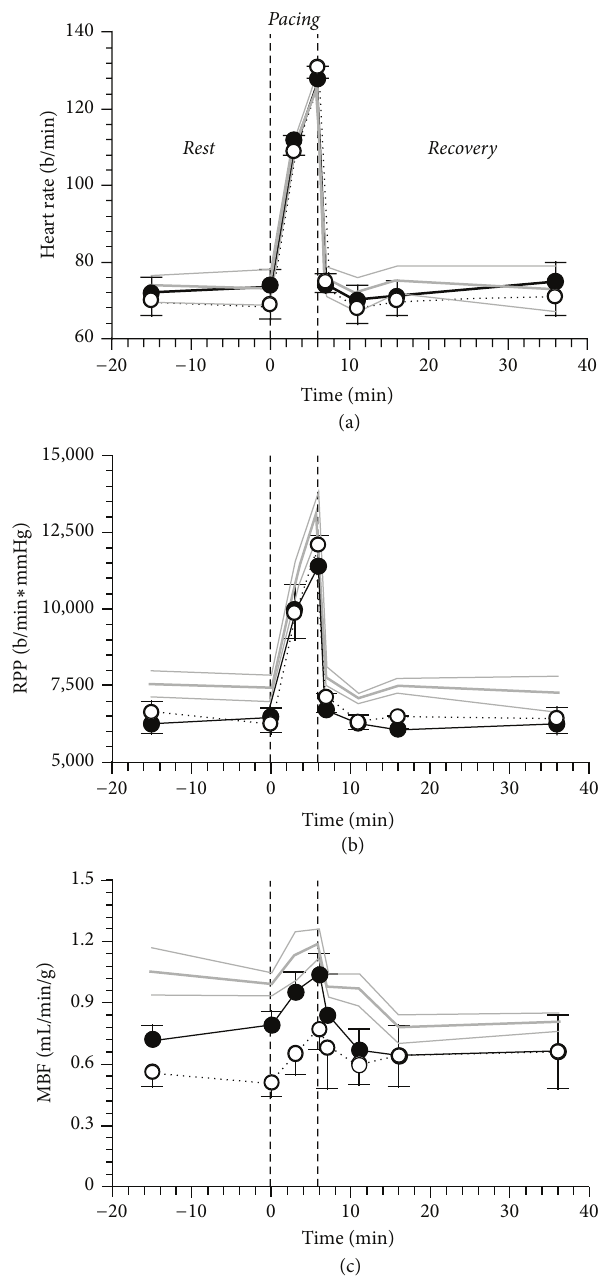
Figure 1: Heart rate, rate pressure product (RPP), and myocardial blood flow (MBF) in 5 N-AGT (gray line), 5 DCM-NGT (dotted black line), and 5 DCM-AGT (continuous black line) in the 3 phases of the study protocol: Rest , Pacing , and Recovery . The plotted values are mean ± SEM. The thin gray lines represent the SEM of the N-AGT